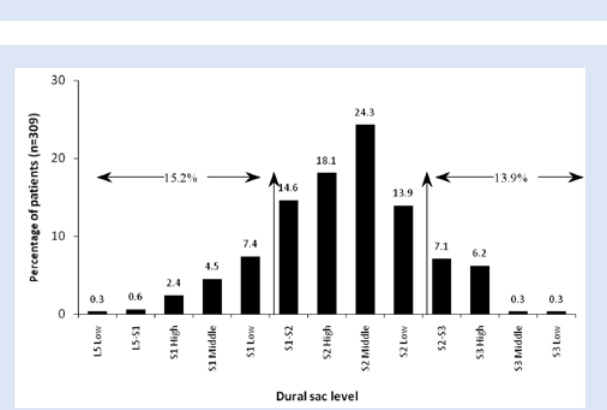
Fig. 1. A midline, sagittal, T2-weighted, spin-echo MR image of the lumbosacral spine demonstrating our method for determining the position of the tip of the dural sac.